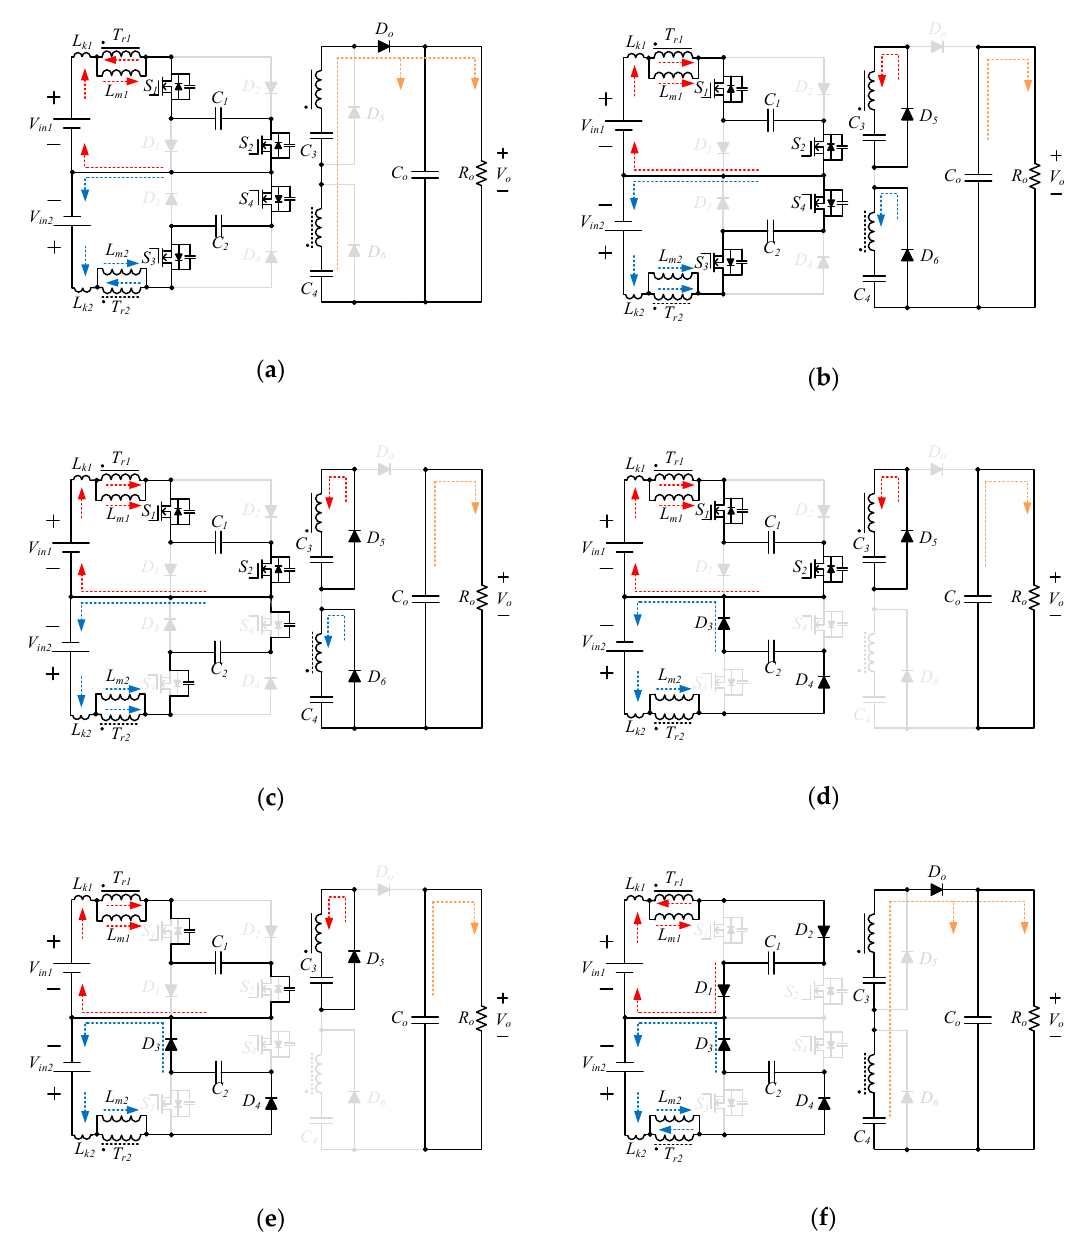
Figure 4. The equivalents of the proposed converter at DIO and CCM operation: ( a ) State 1, ( b ) State 2, ( c ) State 3, ( d ) State 4, ( e ) State 5, ( f ) State 6.